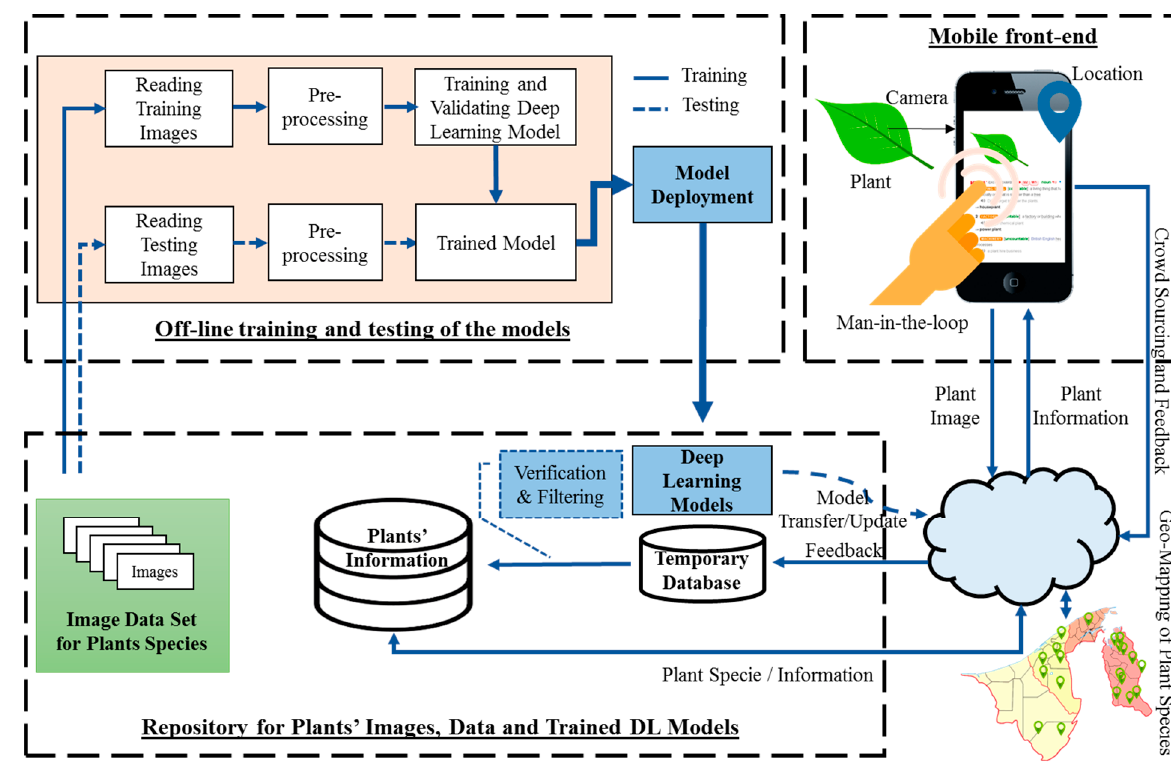
Figure 1. Mobile application system’s architecture.